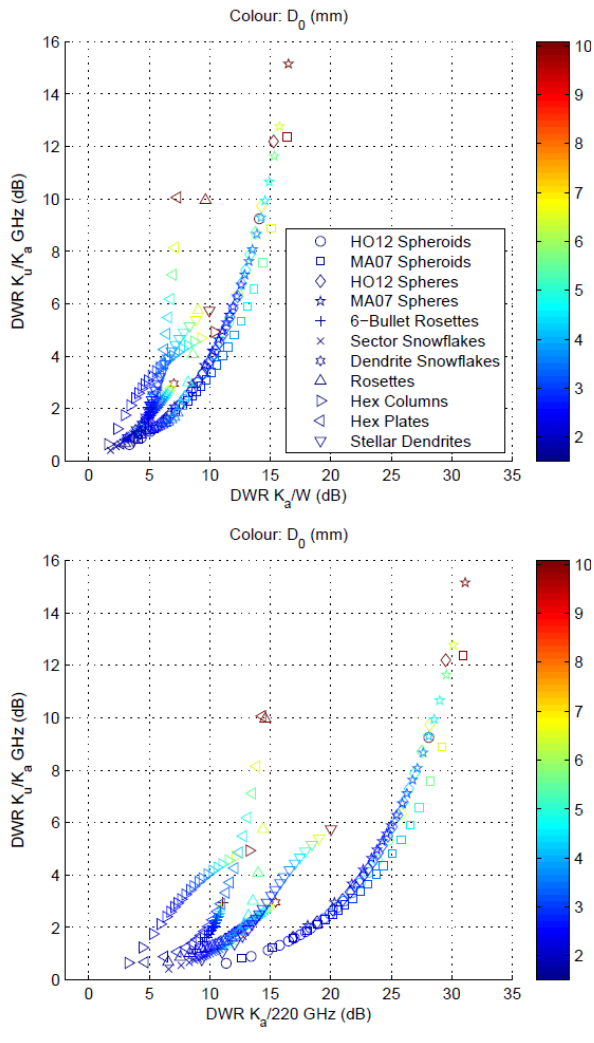
Figure 14. Dual-wavelength reflectivity (DWR) ratios plotted against one another in two different triple frequency combinations: K u –K a –W (top) and K u –K a –220GHz